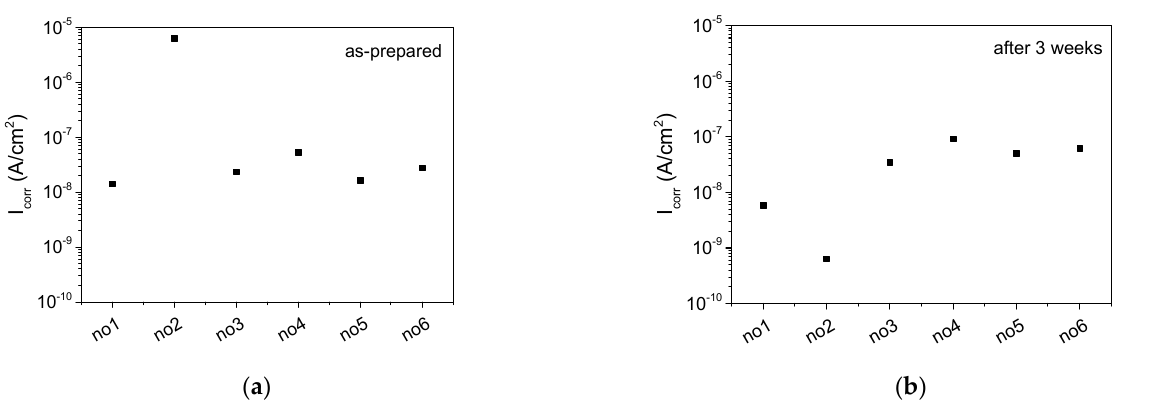
Figure 7. Corrosion rate of Cu in inhibited antifreeze solutions measured ( a ) with as-prepared Cu specimens and solutions and ( b ) with Cu specimens and solutions used for 3 weeks of immersion test.